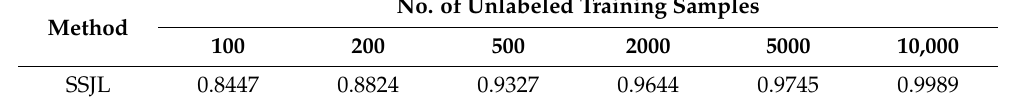
Table 6. Diagnosis accuracies of different numbers of unlabeled training samples on the CWRU dataset.